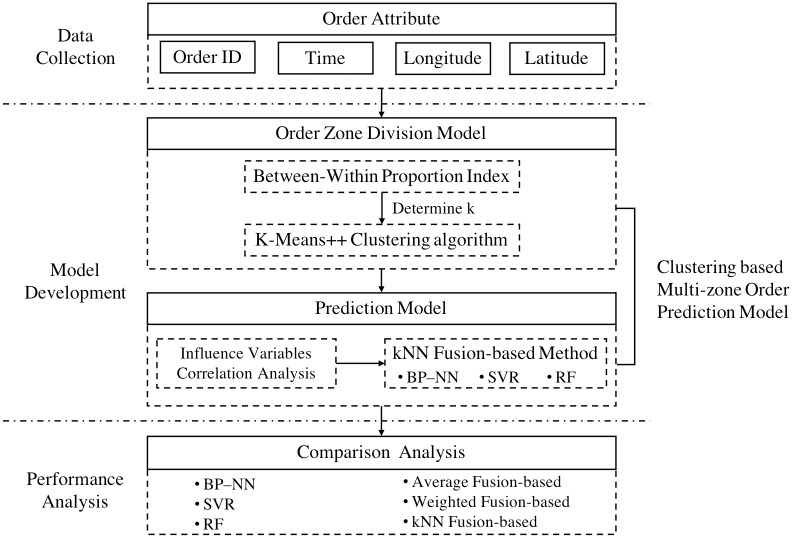
Research framework.